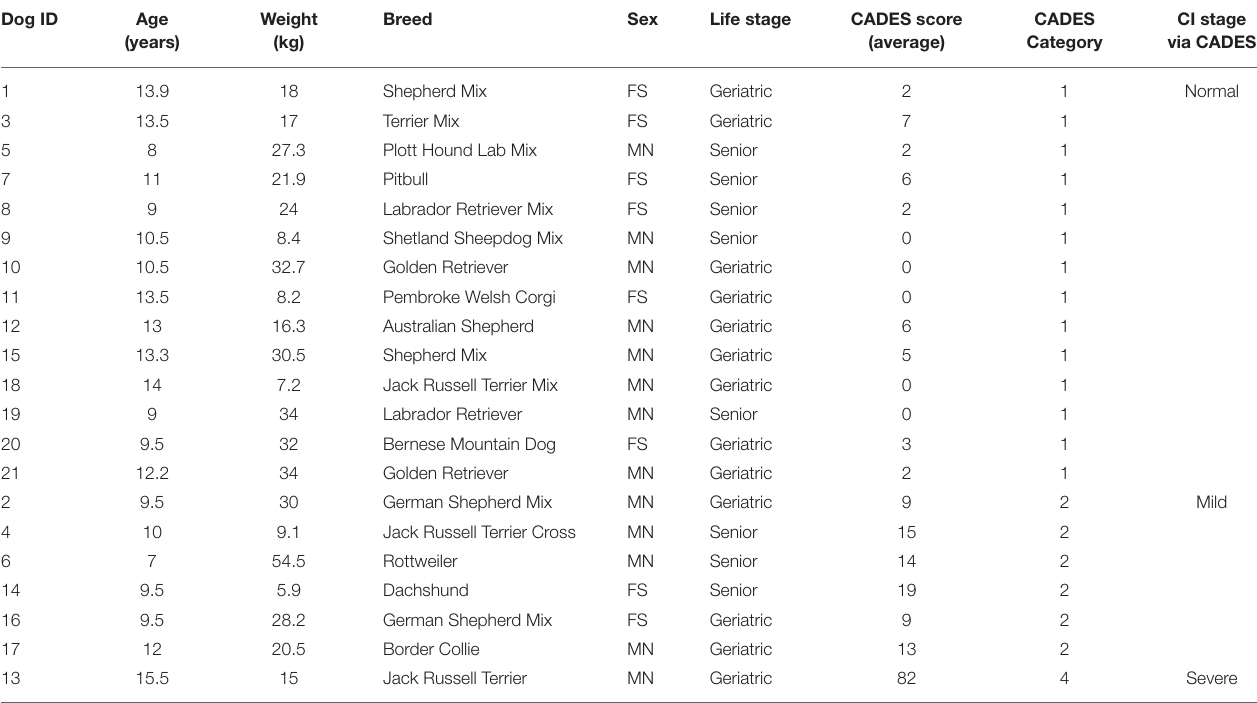
Breed Life stage CADES score